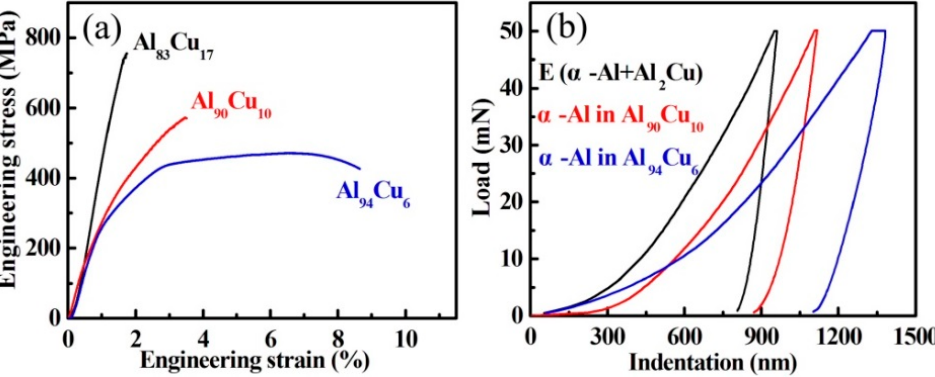
Figure 2. The SEM-EDS analysis of α -Al phase in alloys Al 90 Cu 10 ( a ) and Al 94 Cu 6 ( b ). Figure 2. The SEM ‐ EDS analysis of α -Al phase in alloys Al 90 Cu 10 ( a ) and Al 94 Cu 6 ( b ).